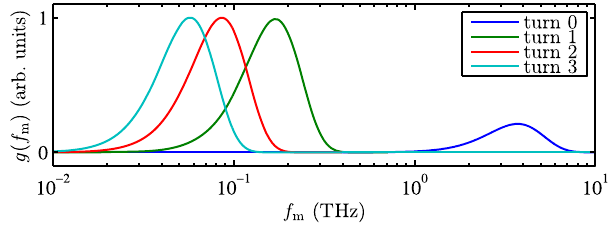
FIG. 2. THz gain curve for the short-pulse facility at DELTA according to Eq. (18) for turn 0 to 3 (see text for details).